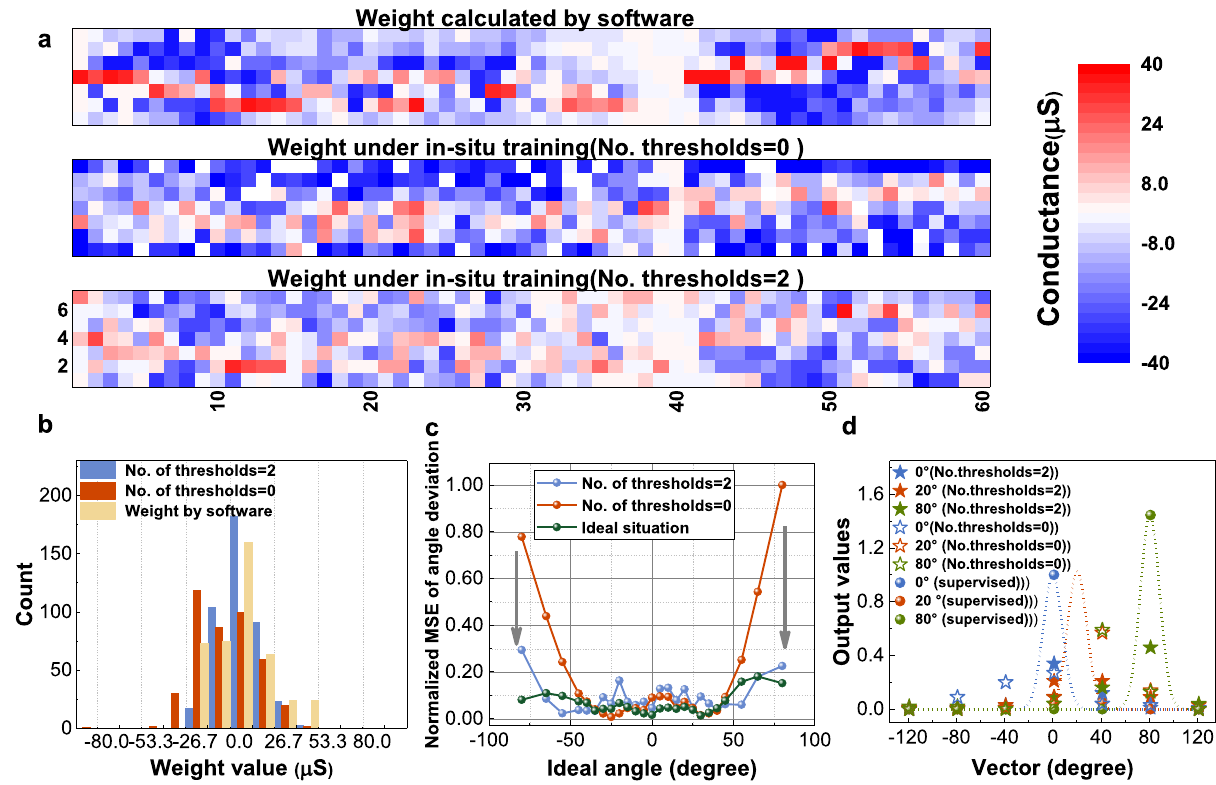
Fig. 4 Experimental demonstration results of sound localization. a The ideal weights and the measured trained weights under the number of thresholds = 0 and 2. b The weight statistical distribution results under various in situ training schemes and ideal weights. c The normalized mean square error (MSE) of the experimental results under the number of thresholds = 0 and 2. d The ideal and experimental outputs of three angle samples with various training